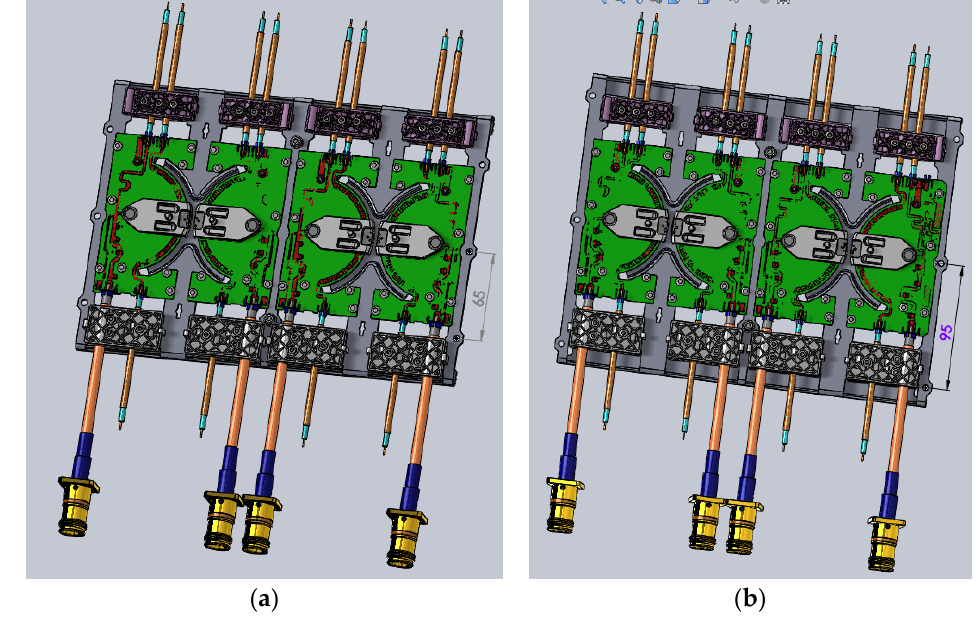
Figure 12. Two designs of phase shifter plate: ( a ) the original design; ( b ) the improved design.